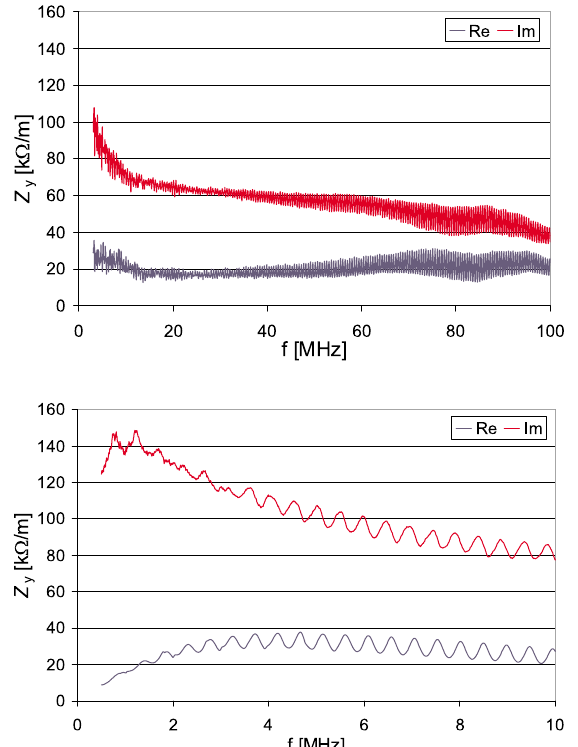
FIG. 28. (Color) Input impedance of production magnets, K26 with TiN coating.FIG. 27. (Color) Estimated coupling impedance of the SNS